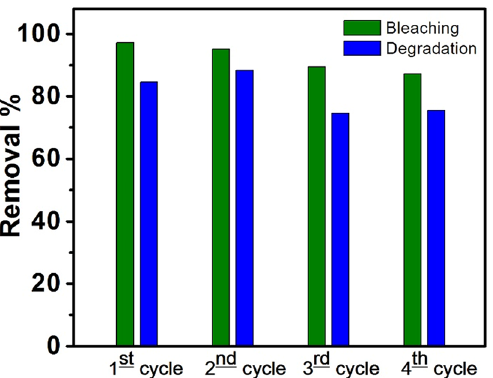
Figure 16. The proposed photodegradation mechanism of MO based CPA/N-SWCNTS-GO-CE/CuO under UV-light irradiation.